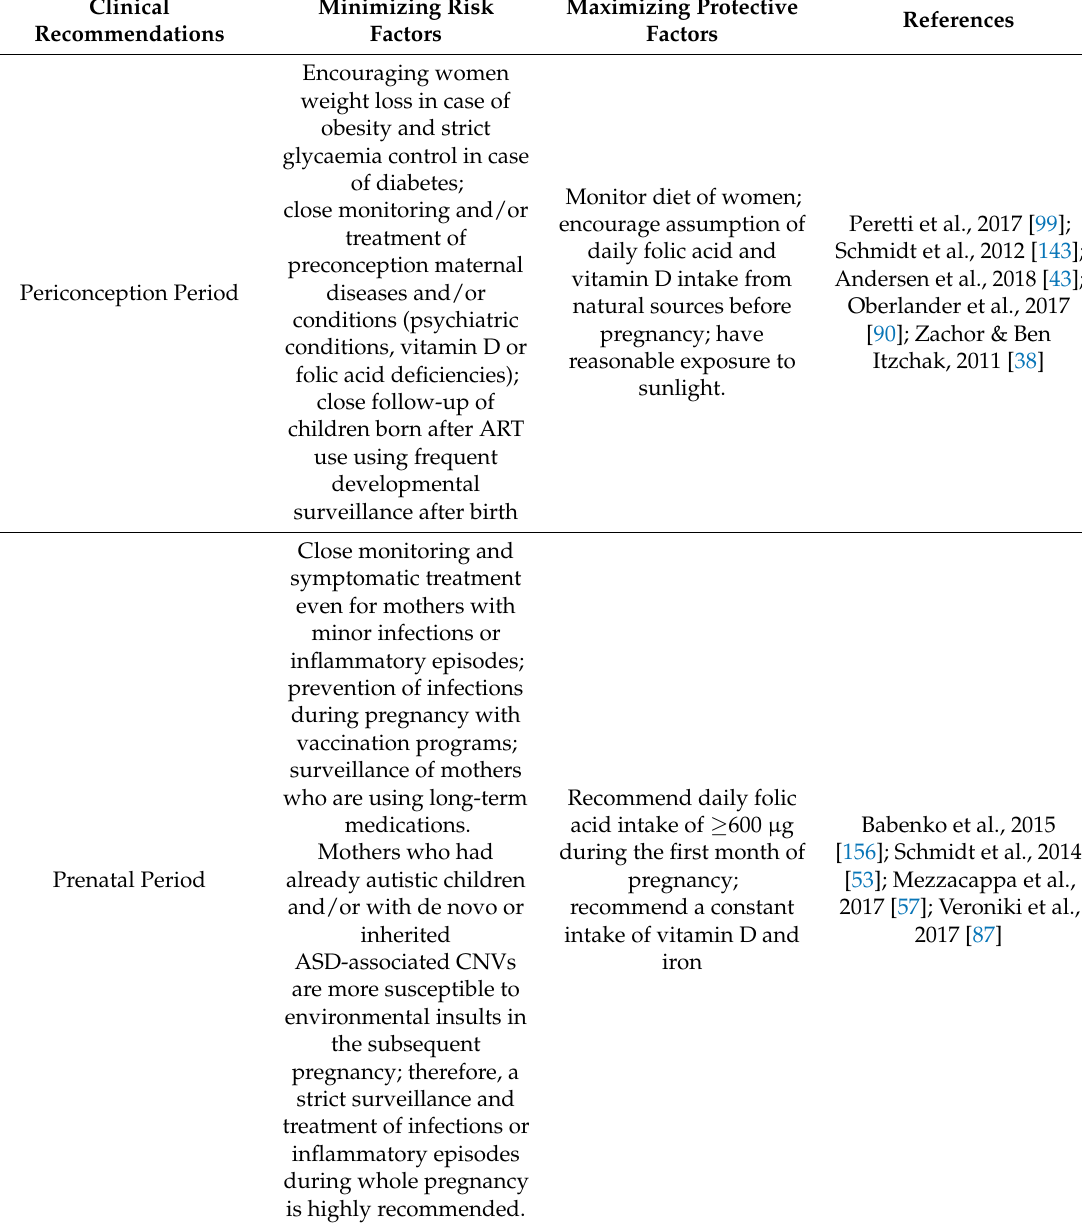
Table 3. Clinical Recommendations for the periconception, prenatal and early postnatal